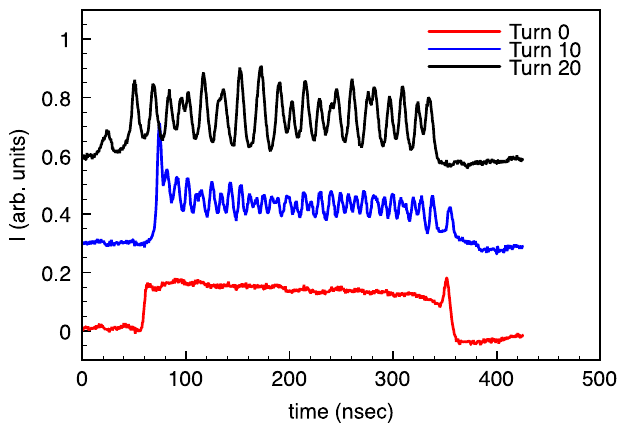
FIG. 2. (Color) Longitudinal bunch profiles measured by the fast Faraday cup after injection and after turns 10 and 20. The profiles measured after 10 and 20 turns are shifted vertically by 0.3 and 0.6, respectively. In these measurements, the beam energy was 20.9 MeV and the peak current was 9 : 3 (cid:3)